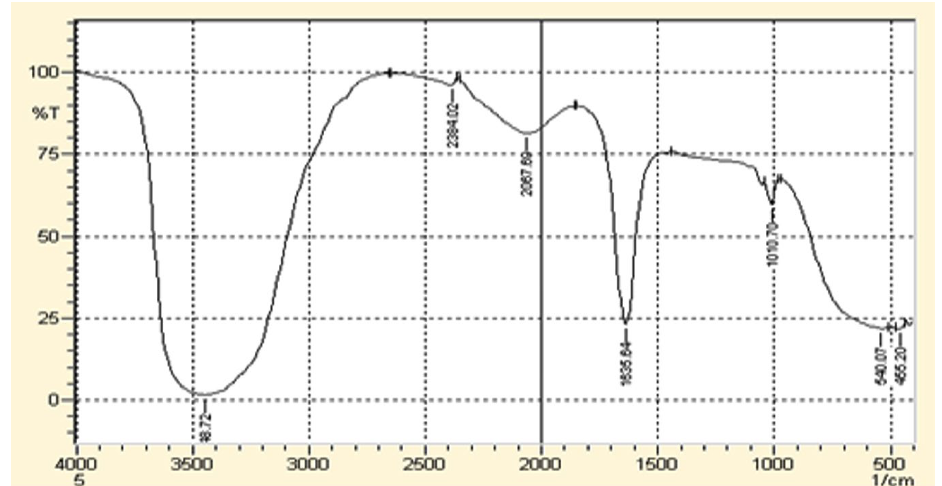
Fig. 3. FT-IR spectrum of synthesized AgNPs from D. salicifolia crude Table 1. Phytochemical analysis of crude extract and fractions of D. salicifolia Chemical constituent